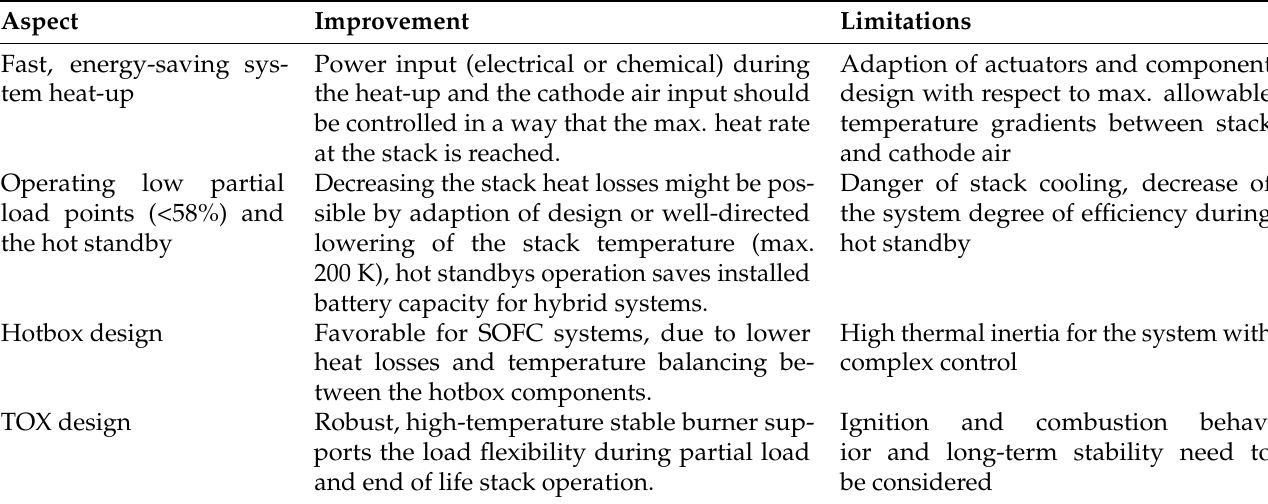
Table 3. Summary of the different aspects for improving SOFC systems regarding the system concept, the design and the opera- tion